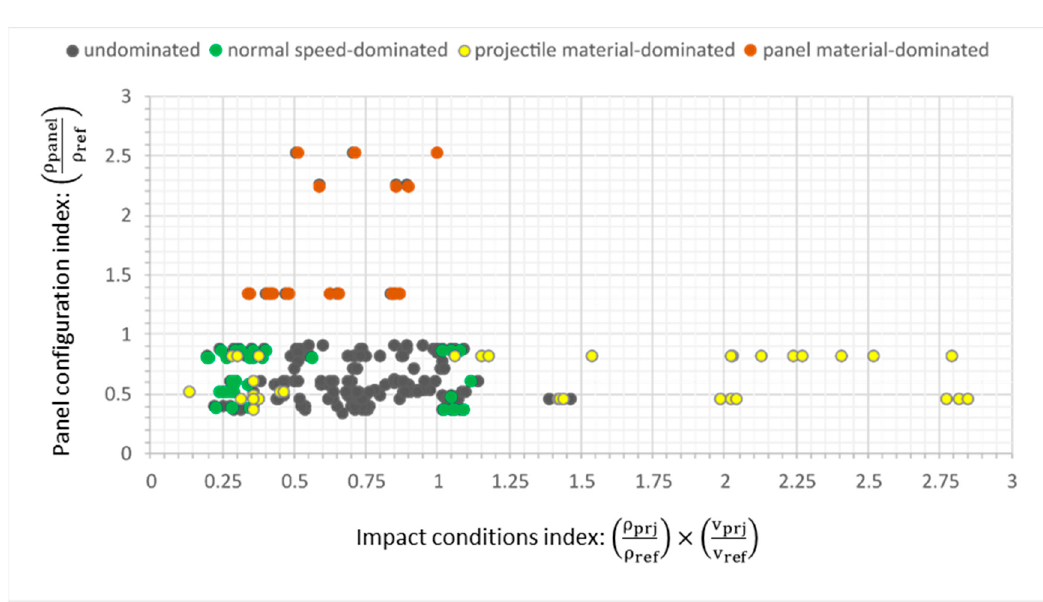
Figure 5. Hypervelocity impacts (HVIs) on honeycomb ‐ core sandwich panels (HCSPs): tested panel configurations versus impact conditions used in experiments.